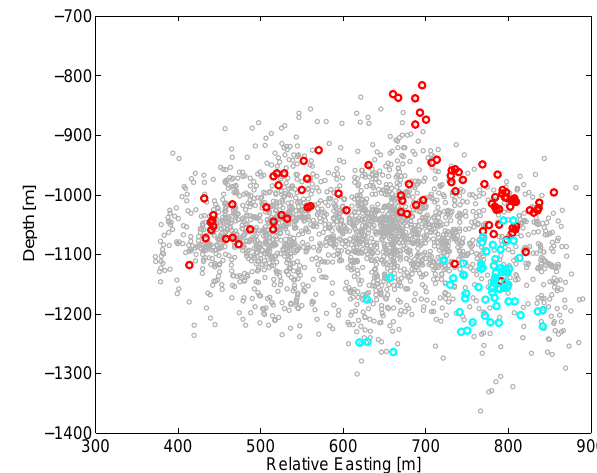
Fig. 12. Depth distribution of events that have been relocated with at least 20 cross-correlation times. Only the three largest clusters detected during the second half of mining operation within the con- fines of longwall S109 are